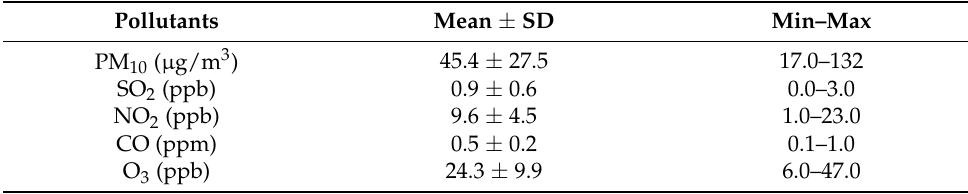
Table 3. Monthly pollutant data (October 2010 to December 2020).